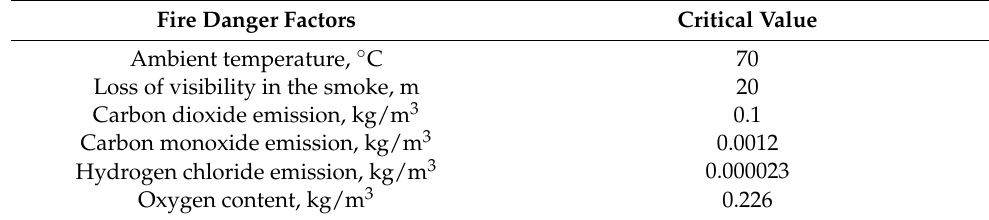
Table 1. Critical values of fire danger